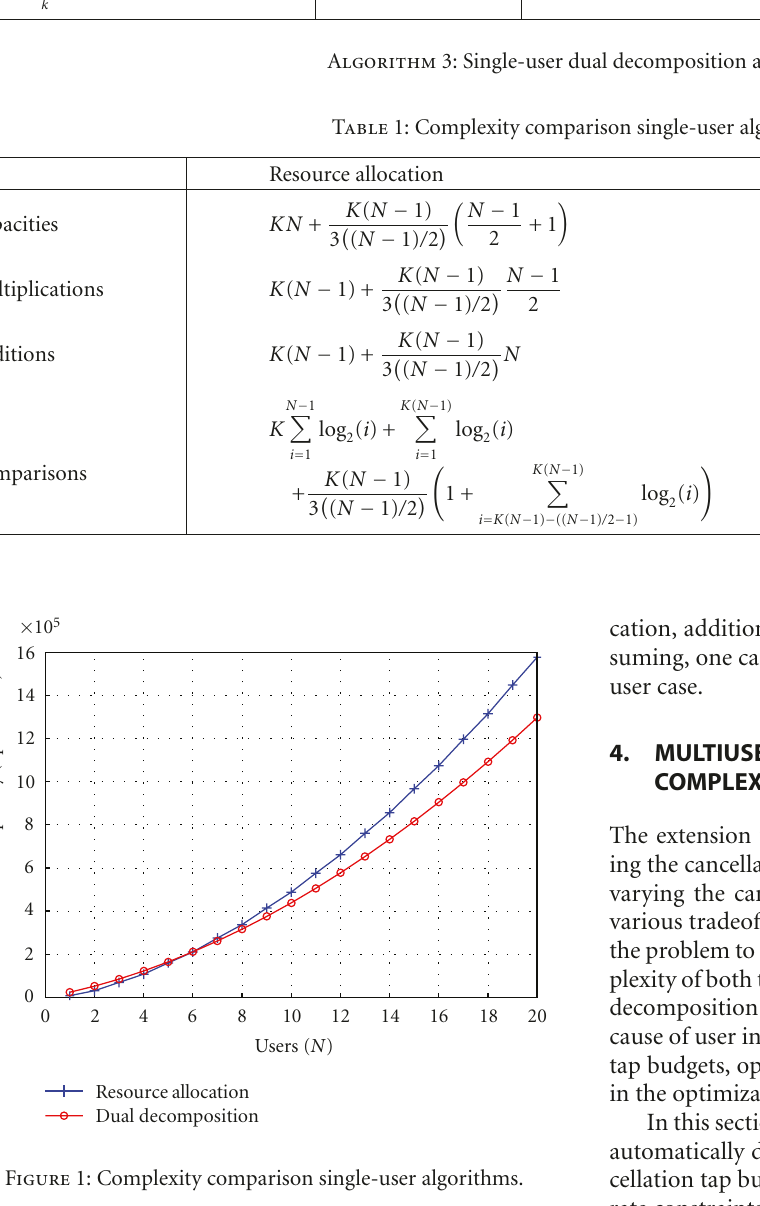
algorithm and the dual decomposition algorithm for K